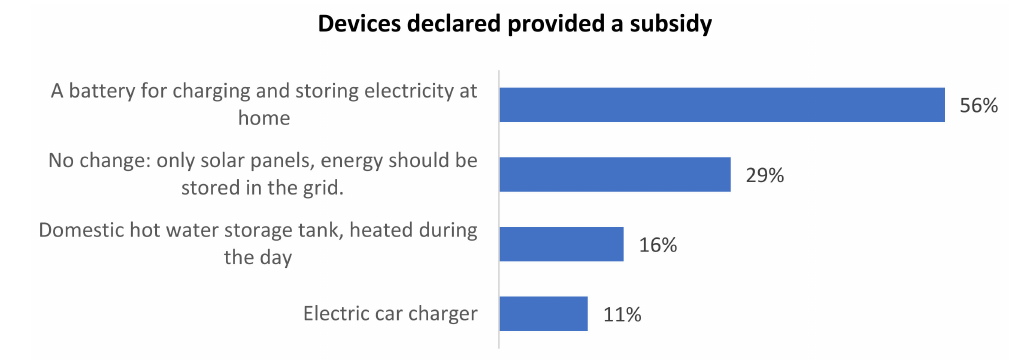
Figure 3. Preferred additional devices for obtaining funding ( n = 57). Source: own study.